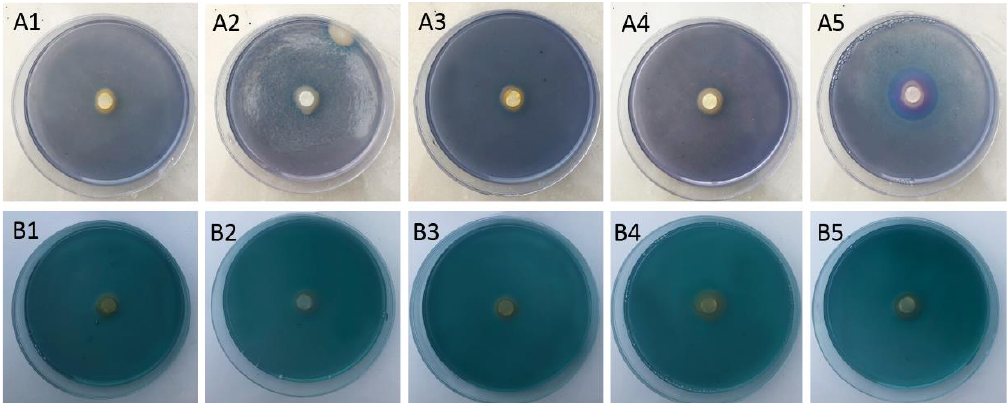
Figure 2. Siderophores production of five strains was determined by inoculating 10 μL bacterial suspension on a sterile filter paper disc (5 mm) that placed into the center of a chrome azurol sulphonate solid medium at different pH and observing the production of orange halo after 3 d of incubation. Bacterial suspension was prepared by incubating cells in iron-deficient minimum salt medium 9 for 24 h and then adjusting the density of cell suspension to 10 7 cfu/mL. A. pH 5.0. B. pH 7.0. 1 – 5: Strains ZJ3-12, ZJ5, ZJ9, ZJ62 and ZJ174.